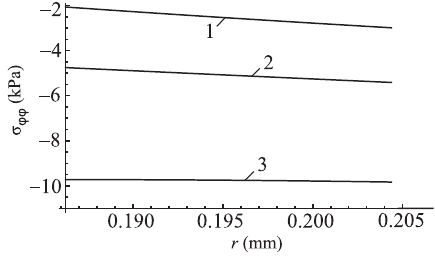
Figure 5. Stress σ ϕϕ vs radial coordinate (circular coordinate ϕ = 0): curves 1, 2, 3 correspond to values ν = 0 . 30;0 . 40;0 . 49, respectively.